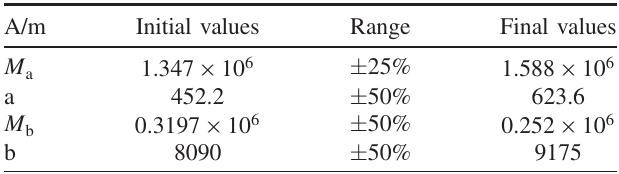
TABLE II. Fitting for Wlodarski curve [Eq. (6)] to MDX. A/m